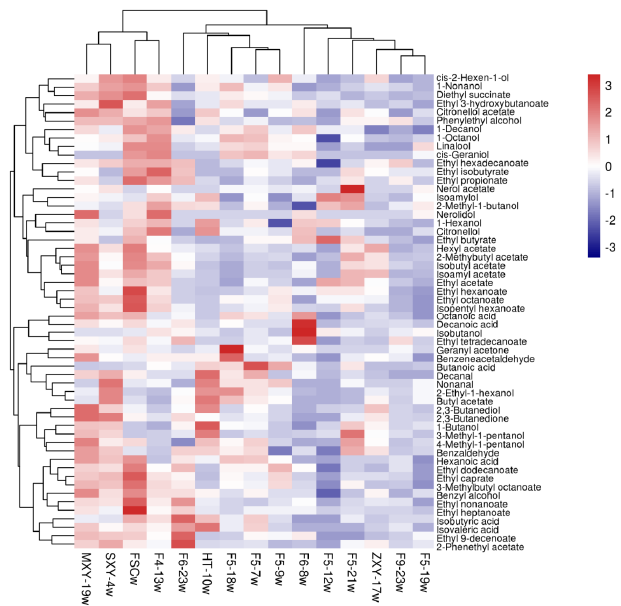
Figure 6. Hierarchical clustering heatmap of volatile aroma compounds of wines fermented by the selected S. cerevisiae strains (all data were normalized). The sensory evaluation of SCw indicated that red fruity, black fruity, fl oral, green, spices, and yeasty were the main aroma traits of wines (Figure 7). Compared with those in FSCw, the red fruity trait in F4-13w, F5-21w, F5-18w, F5-12w, HT-10w, MXY-19w, F6- 8w, F6-23w, and ZXY-17w was improved, especially in F4-13w, the fl oral trait was en- hanced in F4-13w and SXY-4w, and the green trait with negative odor in SCw was reduced [51]. The spices trait in SCw was almost the same as that in FSCw, apart from F9-23w, F5- 12w, F5-19w, and MXY-19w. However, MXY-19w, F9-23w, and SXY-4w presented a mild yeasty trait, which exhibited strong fl occulation ability (Figure 3D). Bauer , et al. [52] indi- cated that strong fl occulation ability led to the early deposition of yeast cells during alco- holic fermentation, which resulted in yeasty traits in wines.